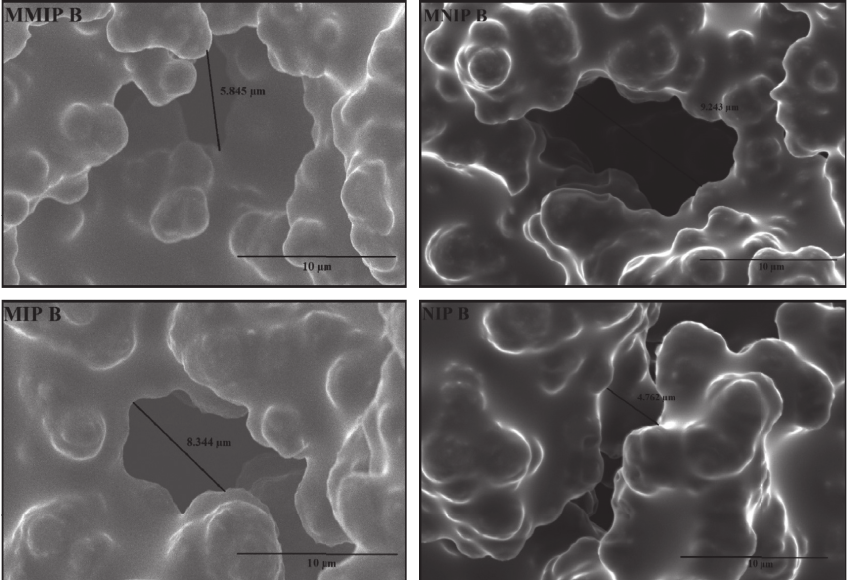
Figure 5: SEM images of monolith prepared with EDMA as the crosslinker at 5000x magnification. The monolith composition can be seen in Table